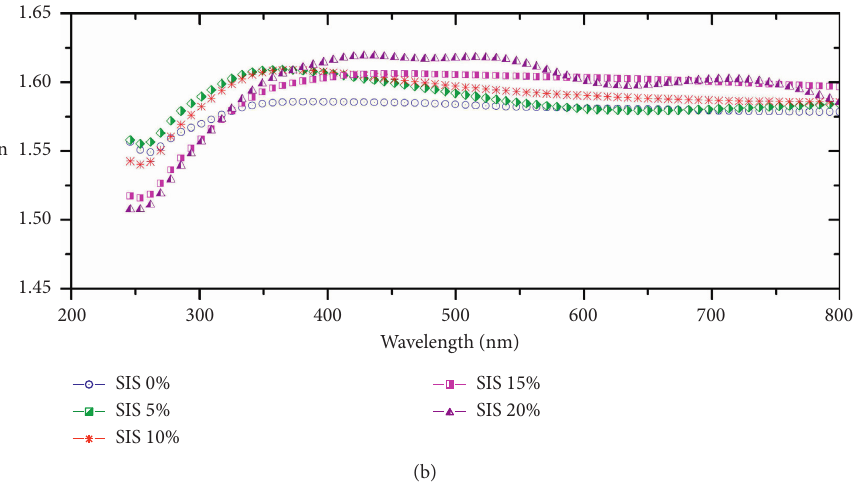
Figure 15: Variation in optical constants ( n , k ) of SIS